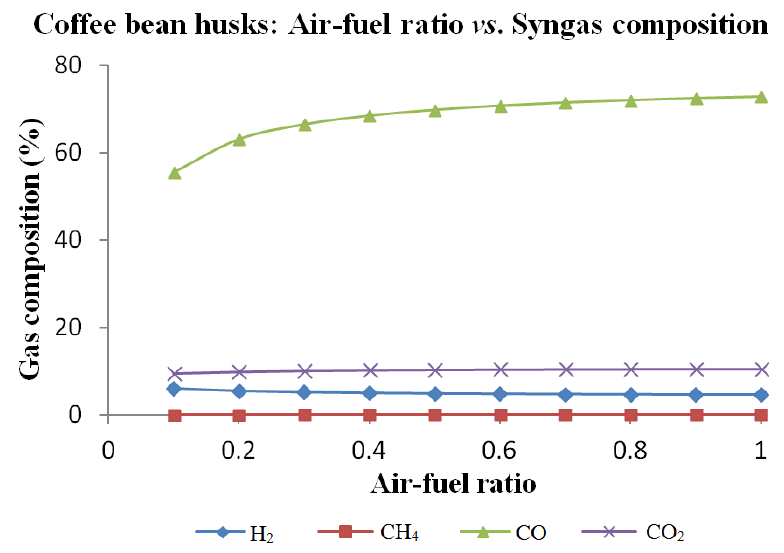
Figure 6. Effect of air-fuel ratio for coffee bean husks (gasifier temperature: 700